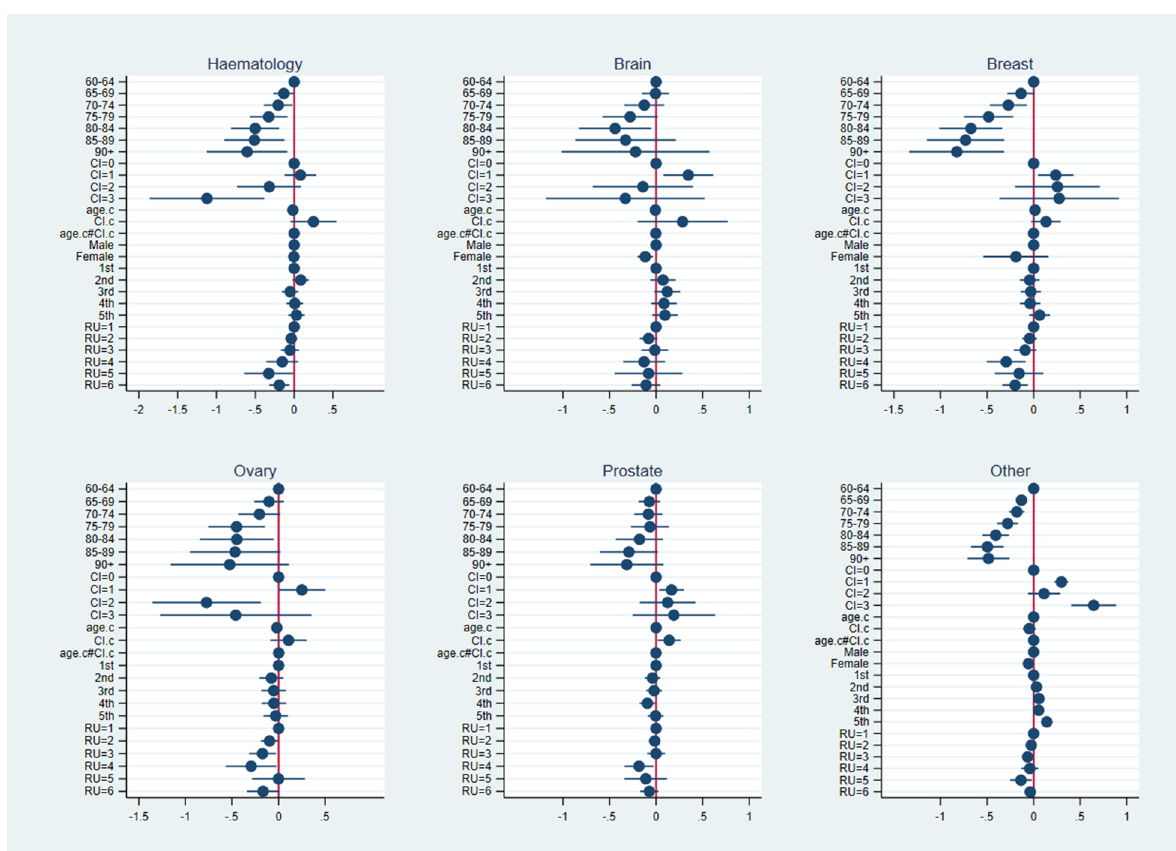
Supplementary Figure 7: Graphical representation of GLM results including interaction term (interaction between age and comorbidity burden) for the different cancer types